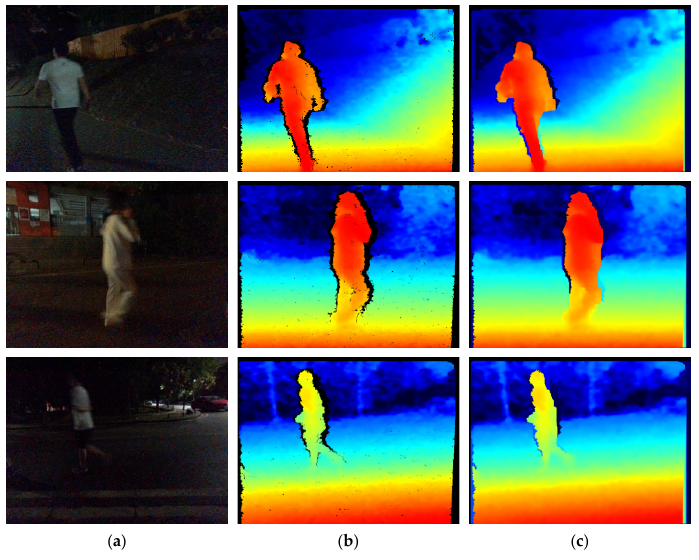
Figure 2. The display of the before and after processing depth images. ( a ) Original RGB images; ( b ) Depth images before processing; ( c ) Depth images after